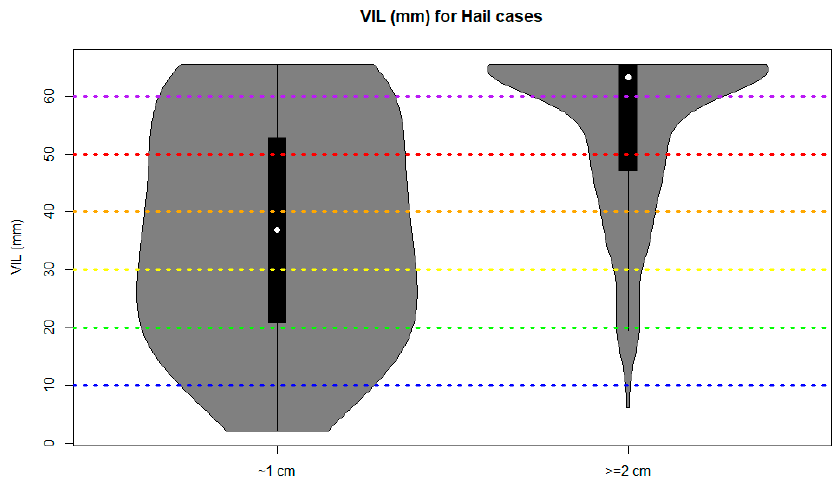
Figure 3. Violin plots for VIL measurements for each of the ground hail registers (Left: for hail close to 1 cm diameter, small hail. Right: for large hail, equal or larger than 2 cm).